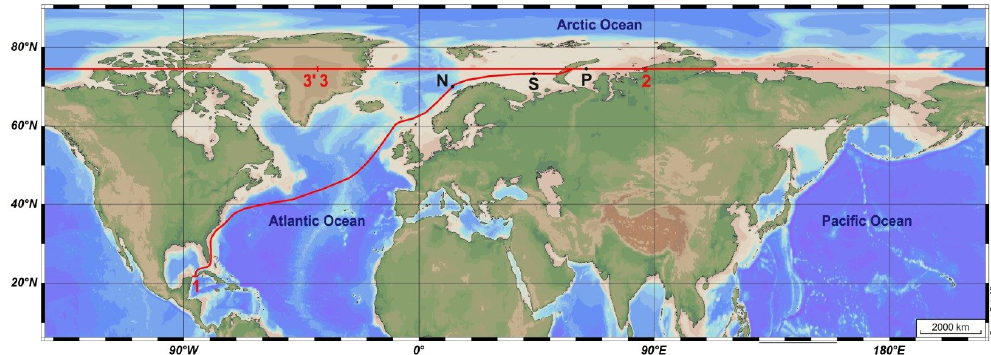
Figure 2. Location of the studied area N and two megaregional lines 1–2 and 3–3’.